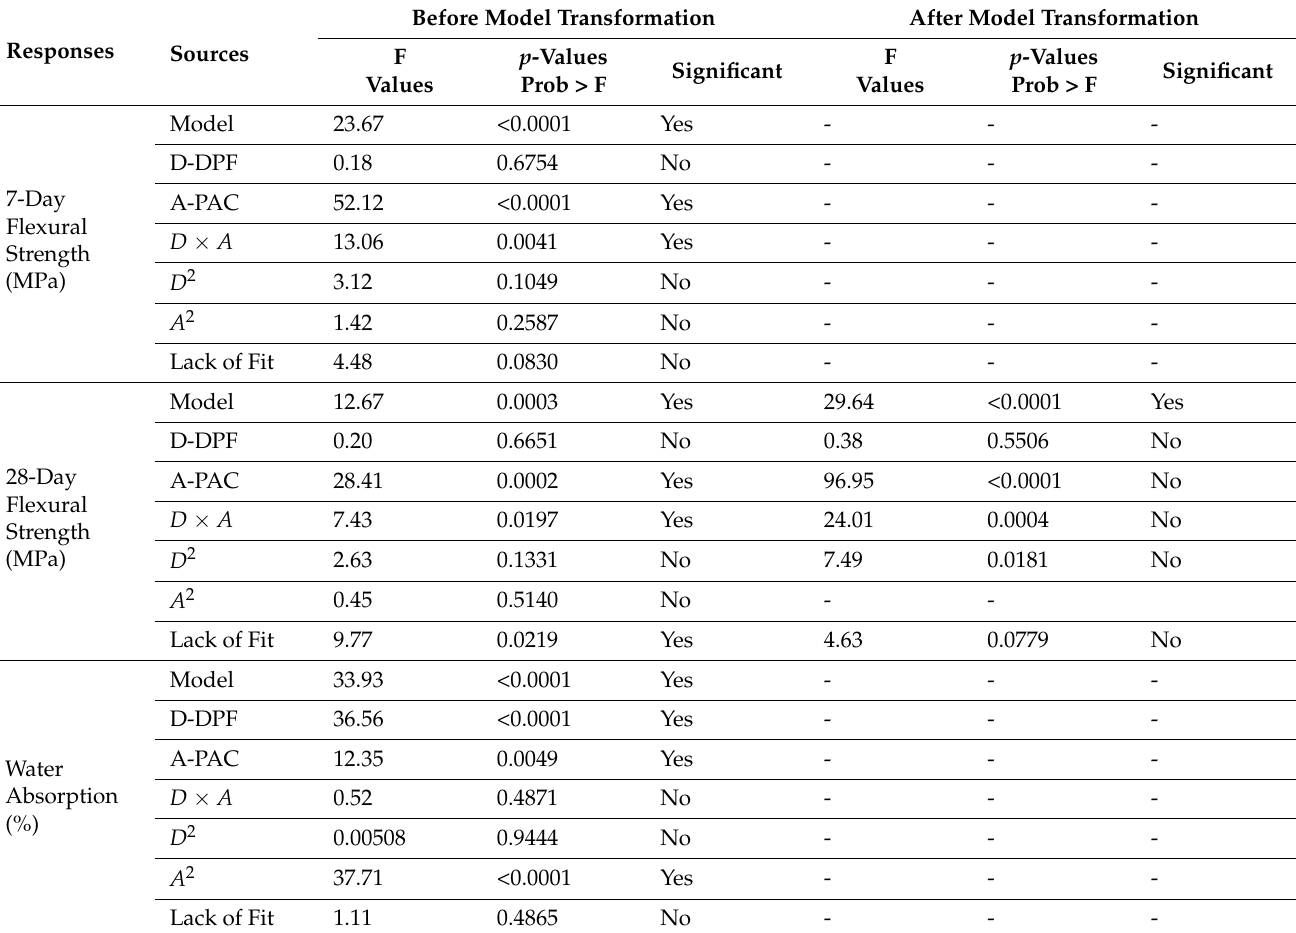
Table 10. ANOVA’s Summary of water absorption and flexural strength models.